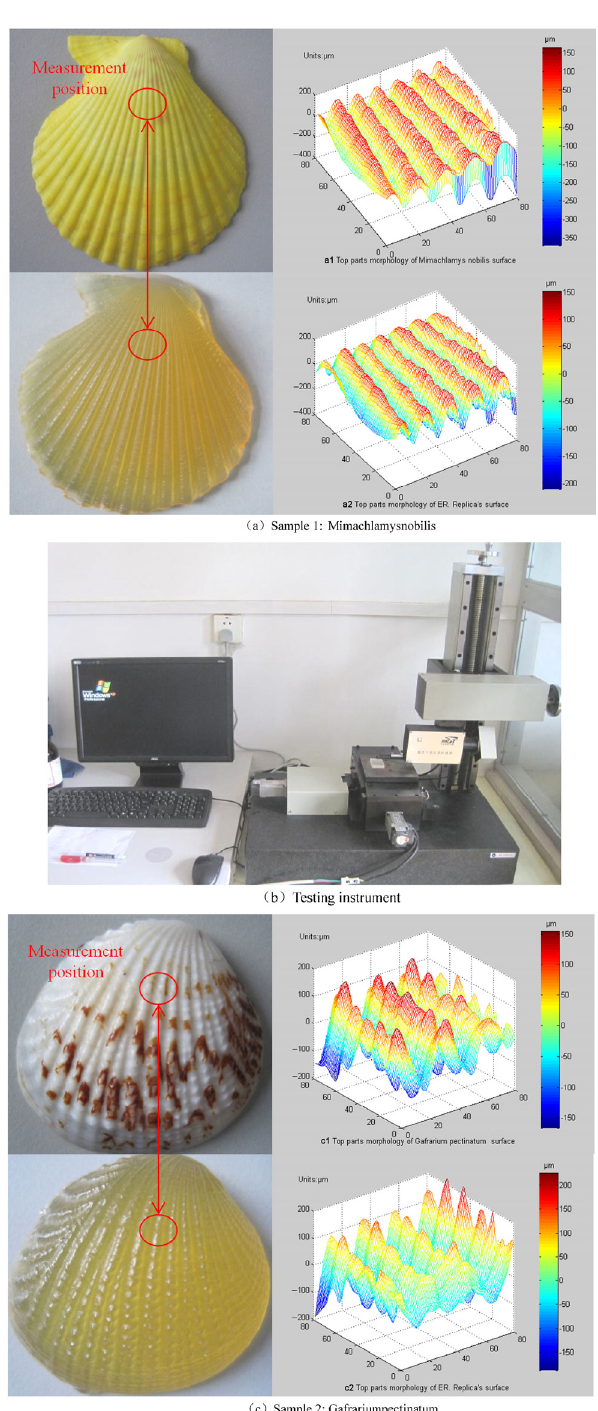
Fig. 12 The shell and its artificial model with microstructure respectively in